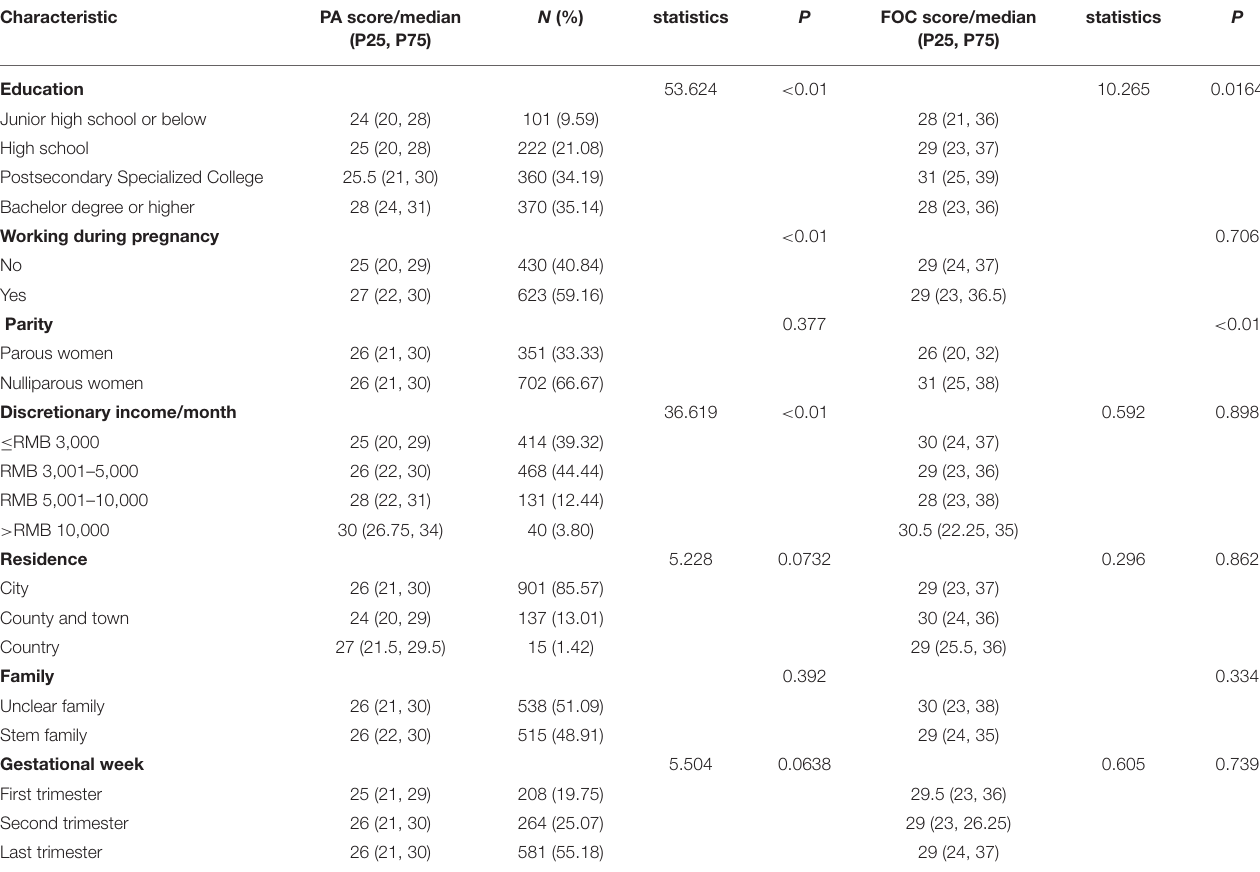
TABLE 1 | PA scores and FOC scores by demographic